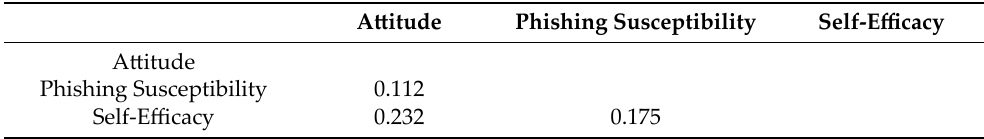
Table 4. Heterotrait–Monotrait Ratio of Correlations